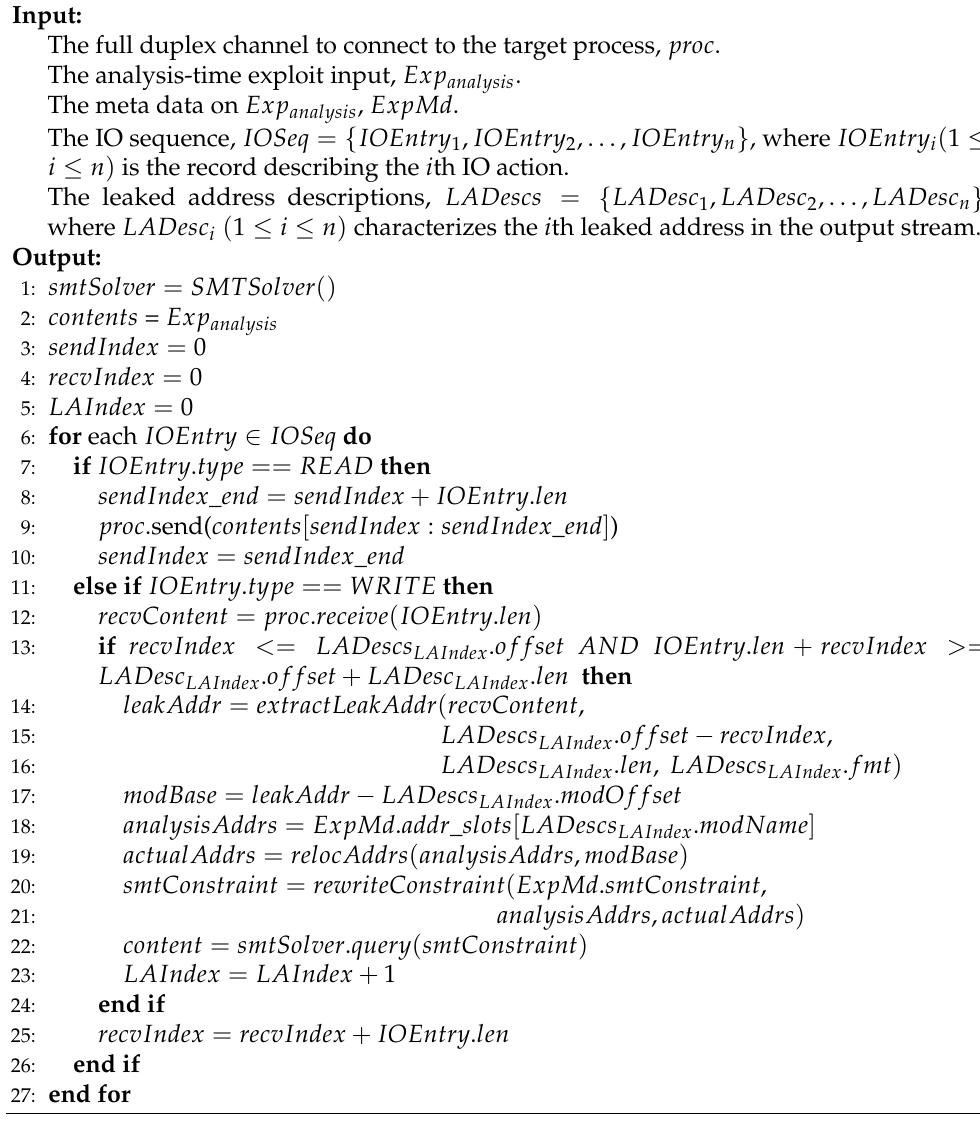
Algorithm 1 Runtime Exploitation Session with Constraint Based Payload